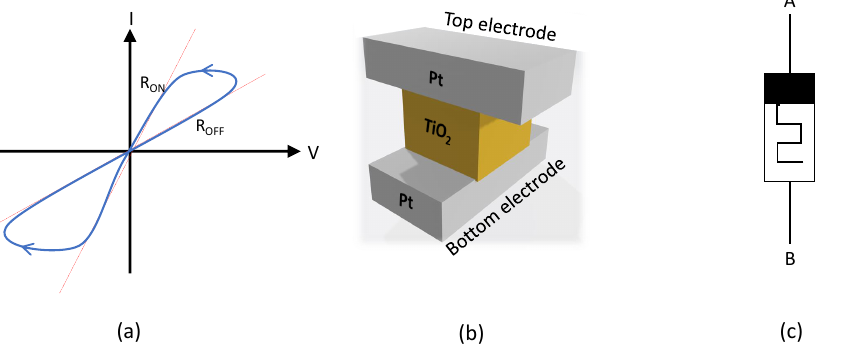
Figure 1. Memristor: ( a ) Pinched hysteresis loop, ( b ) structure: metallic electrodes sandwiching a thin dielectric insulating layer, ( c ) symbol.